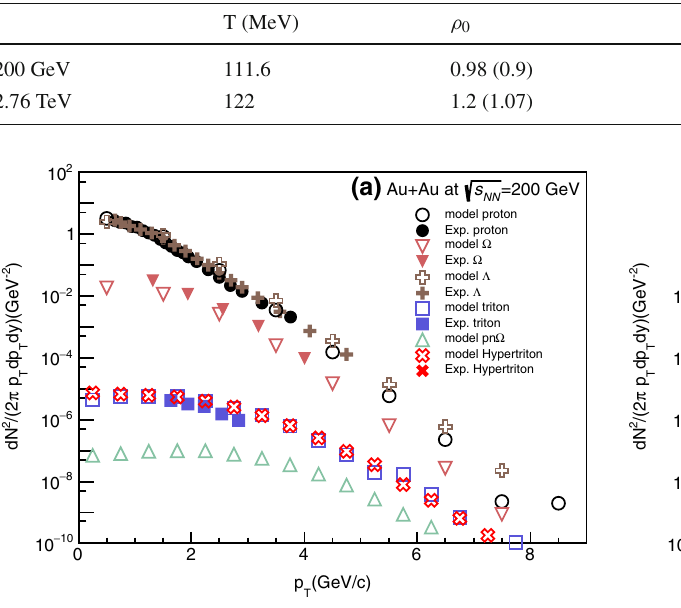
√ s NN = 2 . 76 TeV [19] fitted from the ALICE data [69–71]